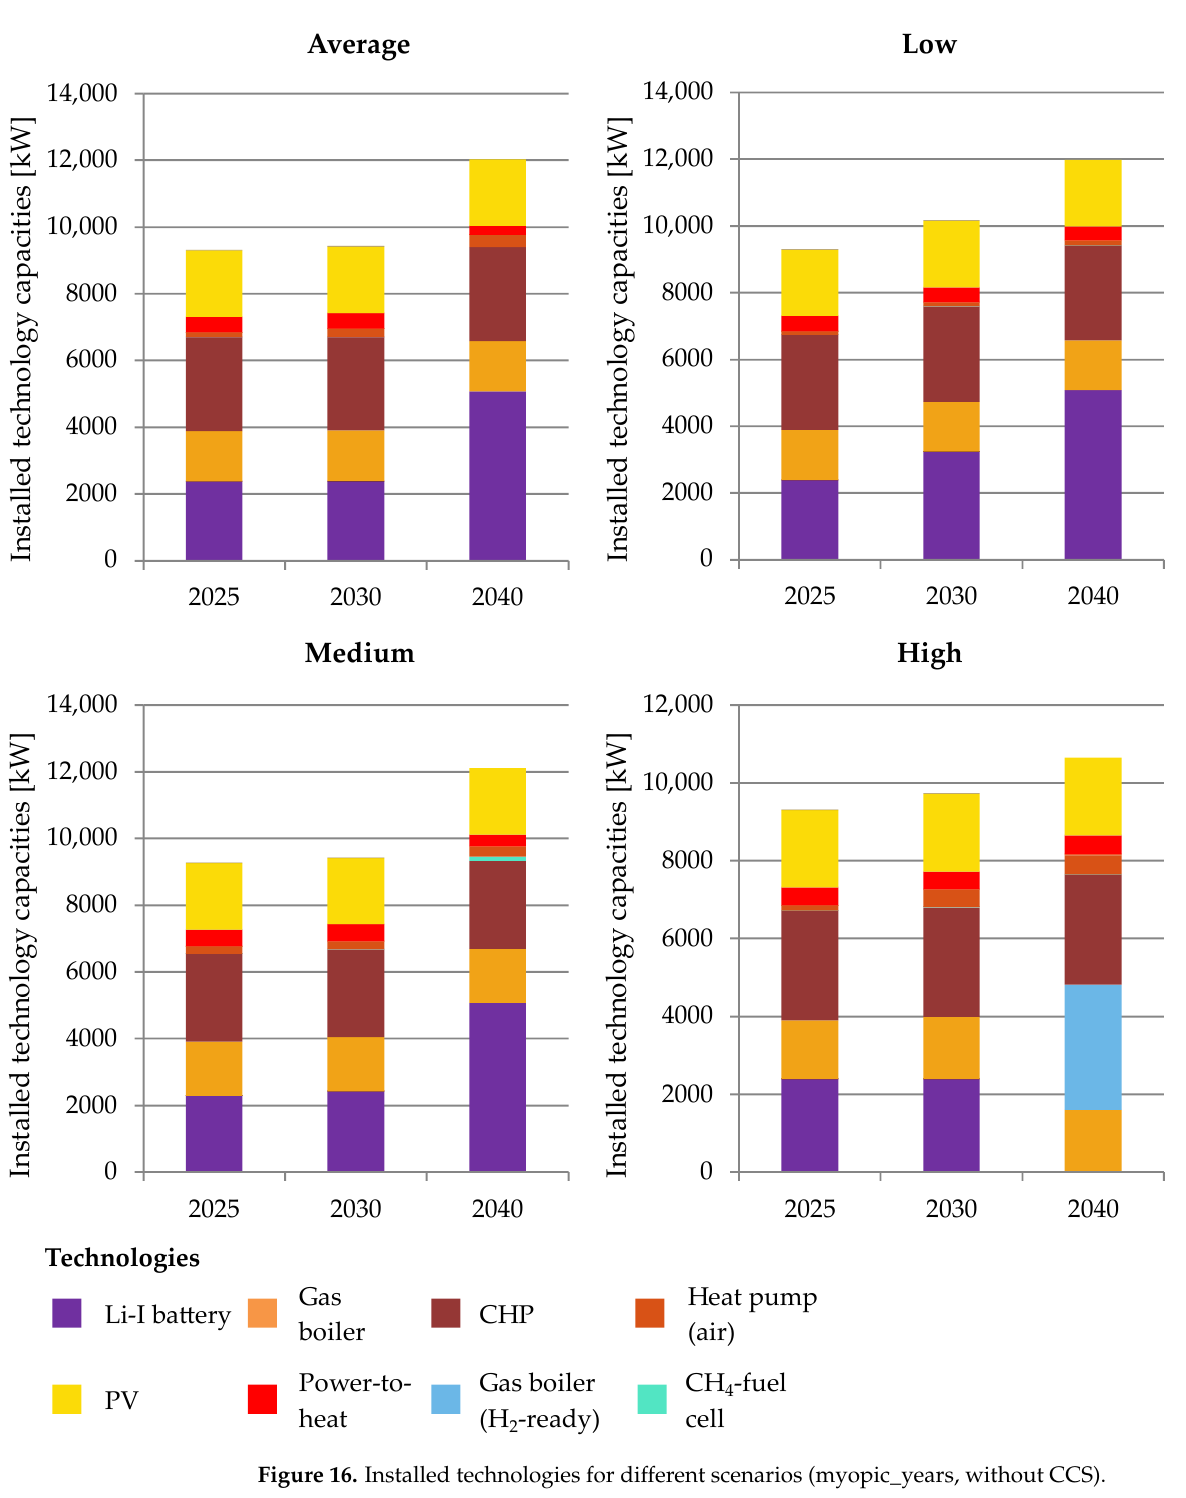
Figure 16. Installed technologies for different scenarios (myopic_years, without CCS). Figure 16 shows that the CHP is still available in the high scenario in 2040, as it has not surpassed its lifetime. However, in the high scenario, the CHP is used only in a very limited way in 2040, as Figure 17 underlines. Therefore, the CHP has a significant overcapacity in 2040 for the high price